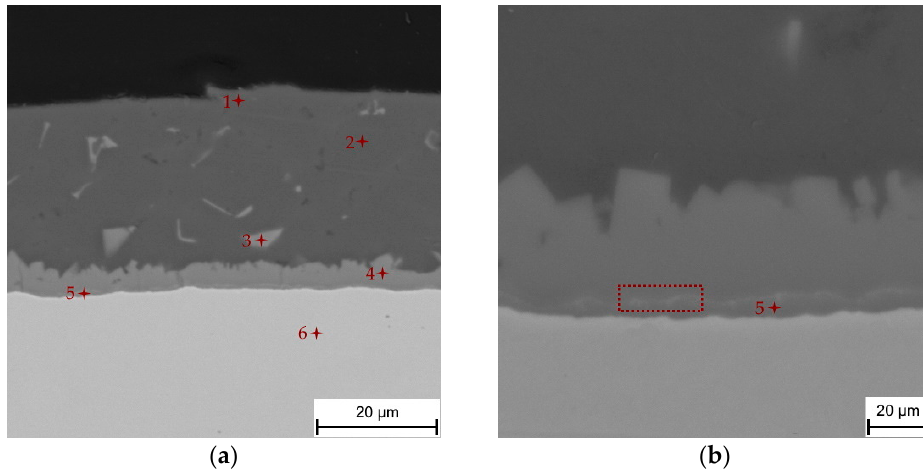
Figure 1. Scanning electron microscope (SEM) micrographs of ( a ) the Al-Si hot-dipped coating on as-received 22MnB5 boron steel and ( b ) a detailed image of the steel/coating interface.